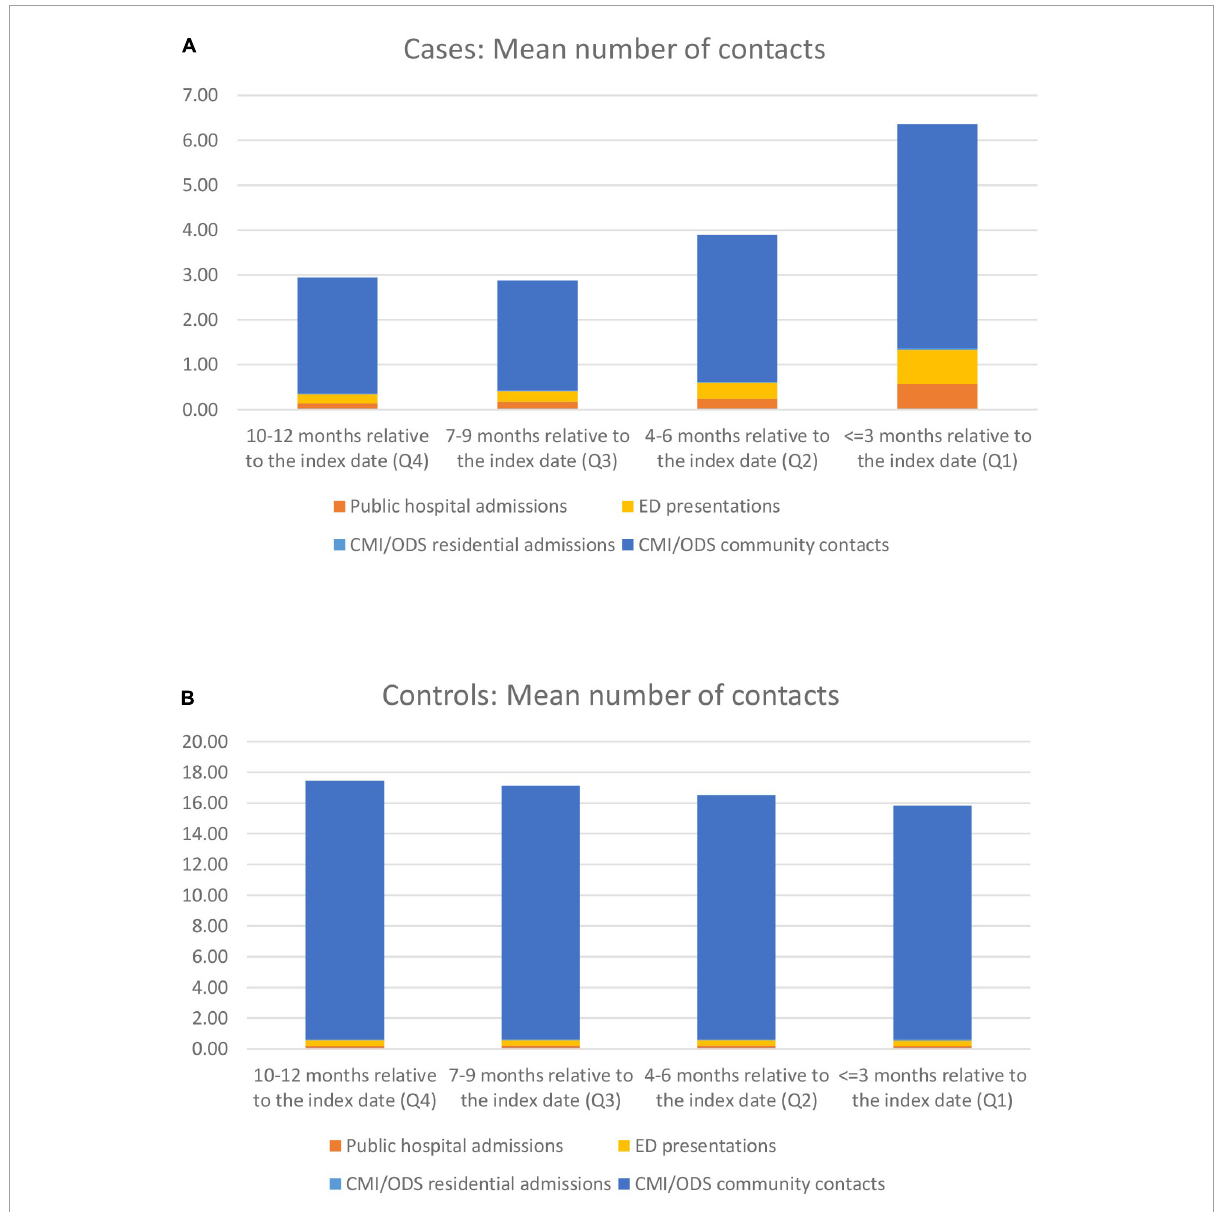
FIGURE4 Mean number of contacts by contact type by quarter for cases and controls (A,B)